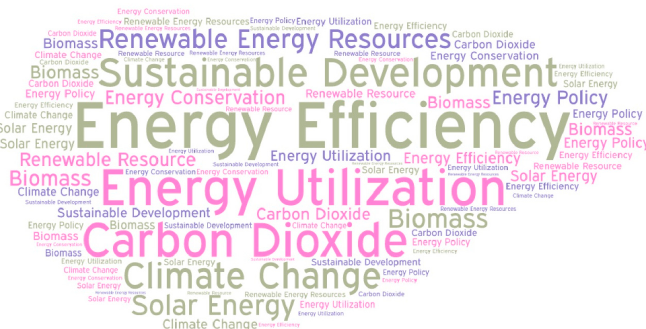
Figure 13. Word cloud based on the main keywords related to renewable energy in urban areas worldwide research. Figure 14 represents a map with the most frequents words that our searching brought to light.